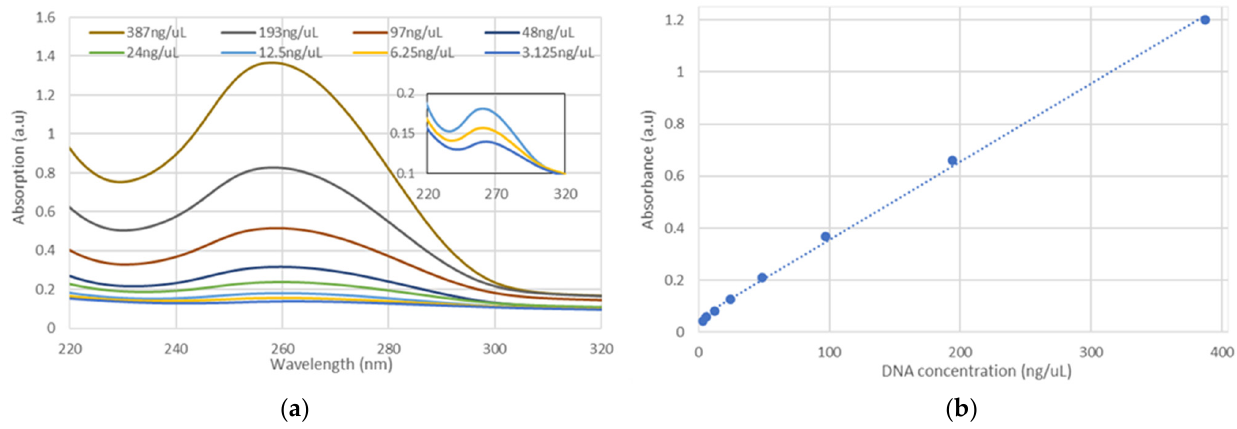
Figure 7. ( a ) UV absorption of different concentrations of DNA in liquid form; ( b ) Peak absorbance values obtained for these concentrations.